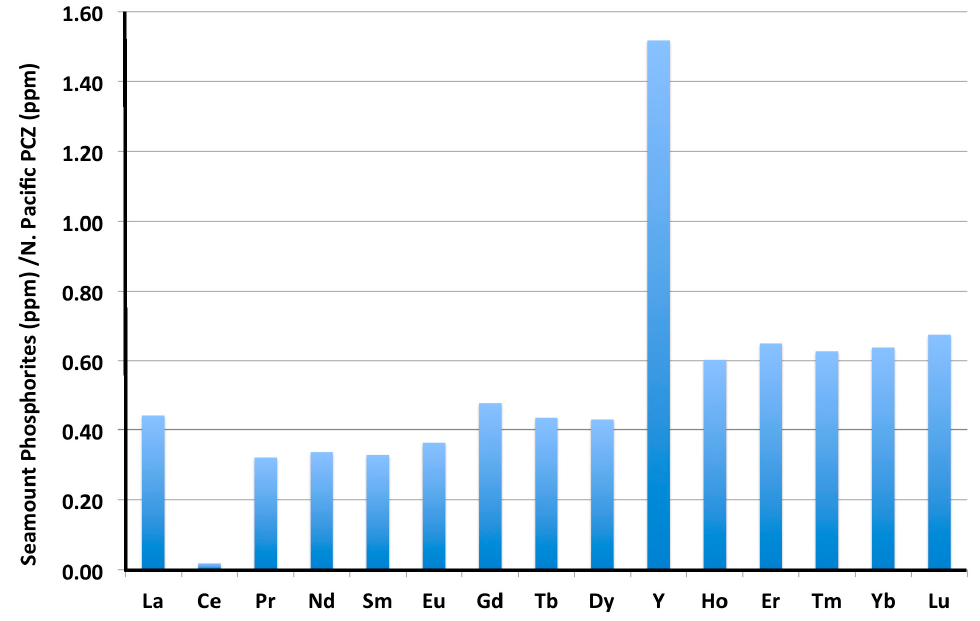
Figure 6. Bar diagram of ratio of mean REY data for seamount phosphorites and Pacific Prime Crust Zone ferromanganese crusts.